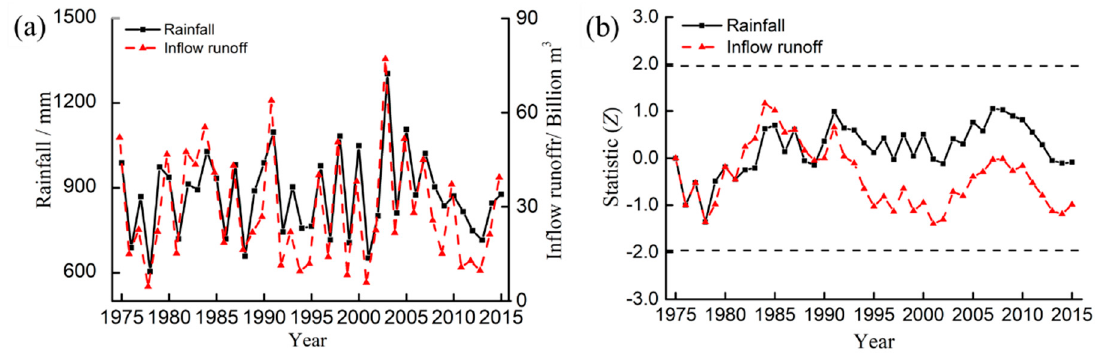
Figure 10. Rainfall and inflow runoff variation process. ( a ) Hydrologic time series; ( b ) M–K statistic analysis.